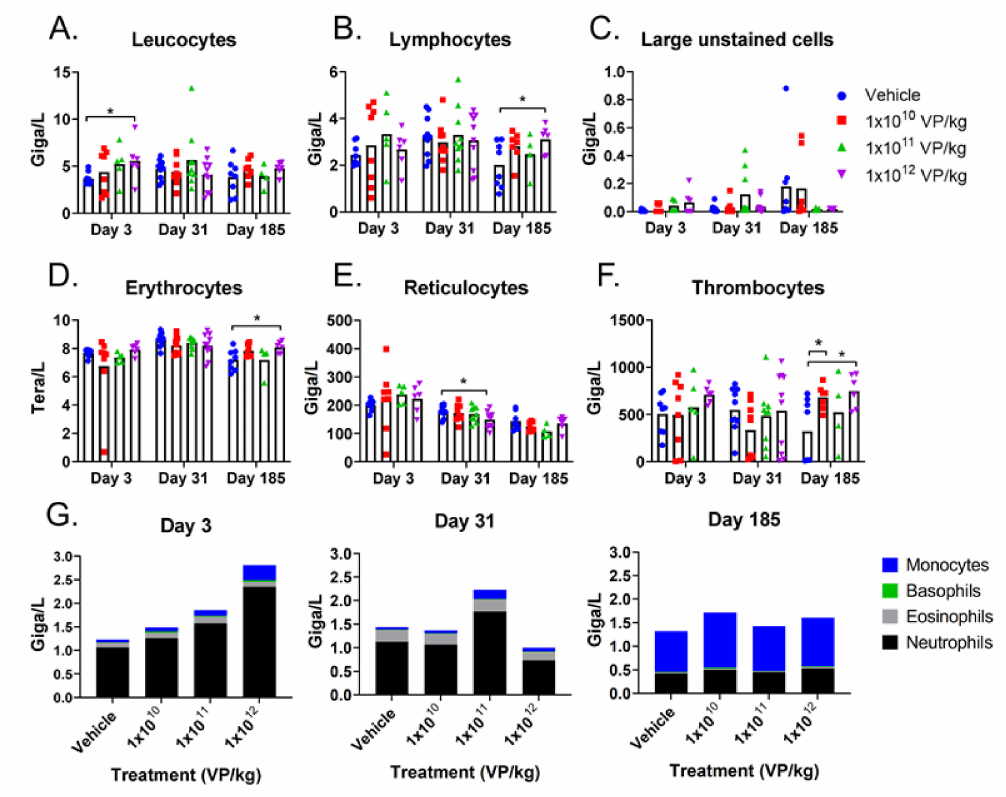
Figure 2. Circulating blood cell levels in hamsters: the hamsters received six TILT-123 injections i.p. at three different doses. Leucocytes ( A ), lymphocytes ( B ), large unstained cells ( C ), red blood cells ( D ), reticulocytes ( E ), thrombocytes ( F ), and myeloblast-derived cells (monocytes, basophils, eosinophils, and neutrophils) ( G ) were counted from the whole blood at three time points (3, 31, and 185 days after the first treatment). The data show the means plus standard error of mean. Statistical significance between the cell number in control group vs. treatment group on each time point was evaluated with the Mann–Whitney test (* p <